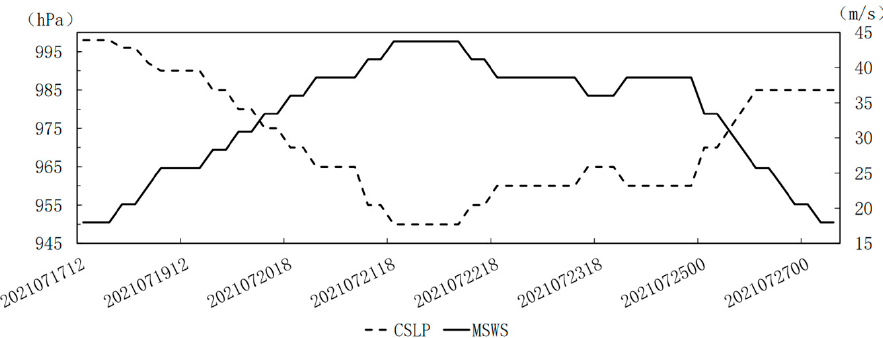
Figure 2. Central sea level pressure (CSLP, unit: hPa) and maximum surface wind speed (MSWS, unit: m · s − 1 ) of In ‐ Fa.